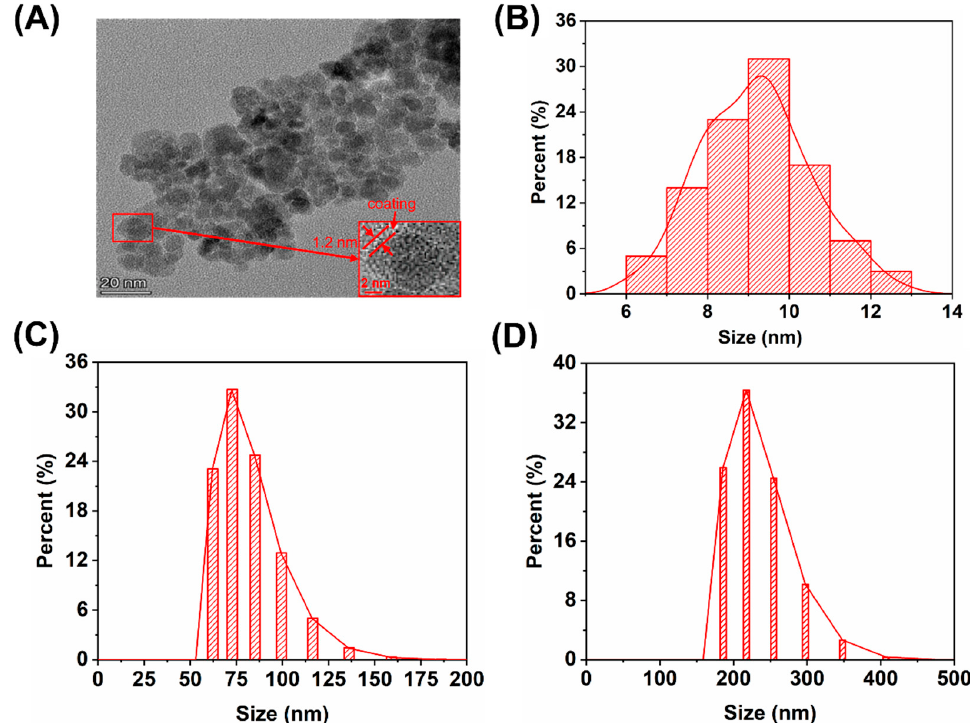
Figure 2. ( A )Transmission electron micrographs and ( B ) particle size distribution maps of Fe 3 O